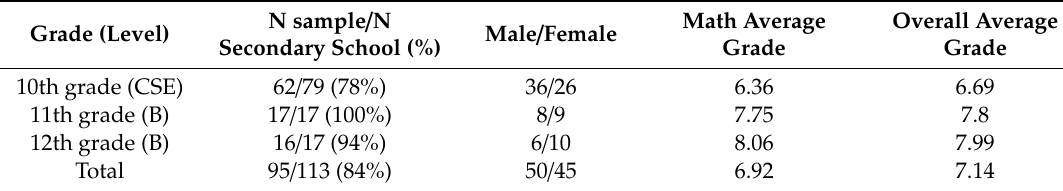
Table 1. Profile of